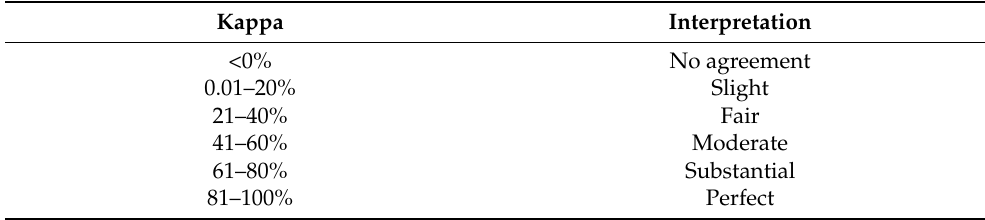
Table 4. The scale of Kappa value interpretation.